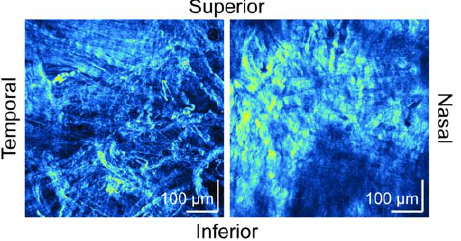
Figure 9. Second-harmonic-generation microscopy images of porcine sclera. The images were taken by a custom-made second- harmonic-generation microscope with an excitation wavelength of 800 nm and excitation pulse duration of 100 fs. The scale bars indicate 100 m m times 100 m m.